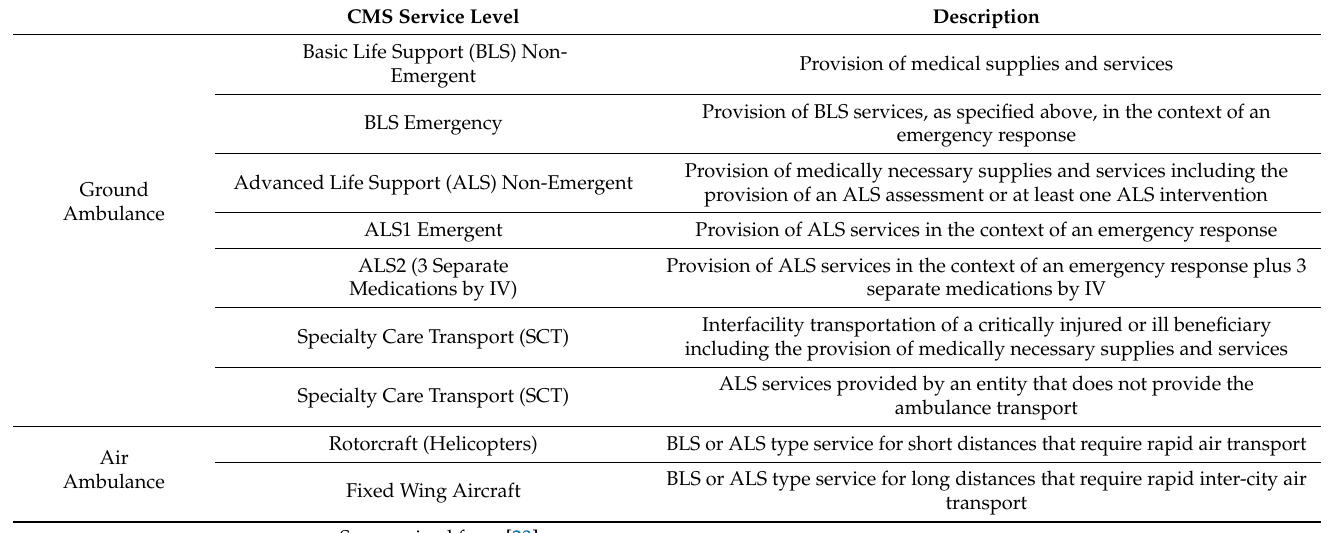
Table 1. Nine ambulance service levels.